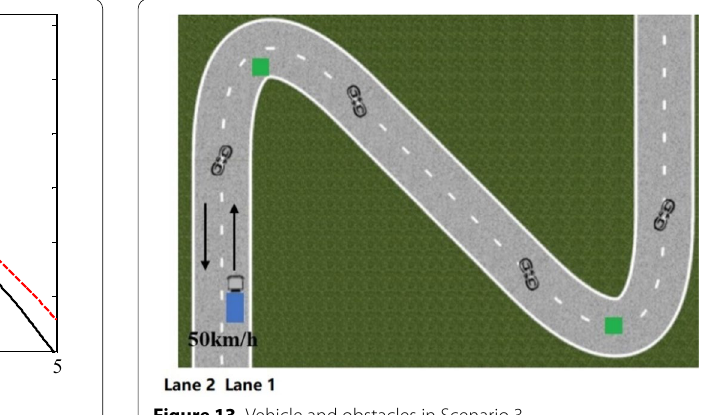
Figure 13 Vehicle and obstacles in Scenario 3